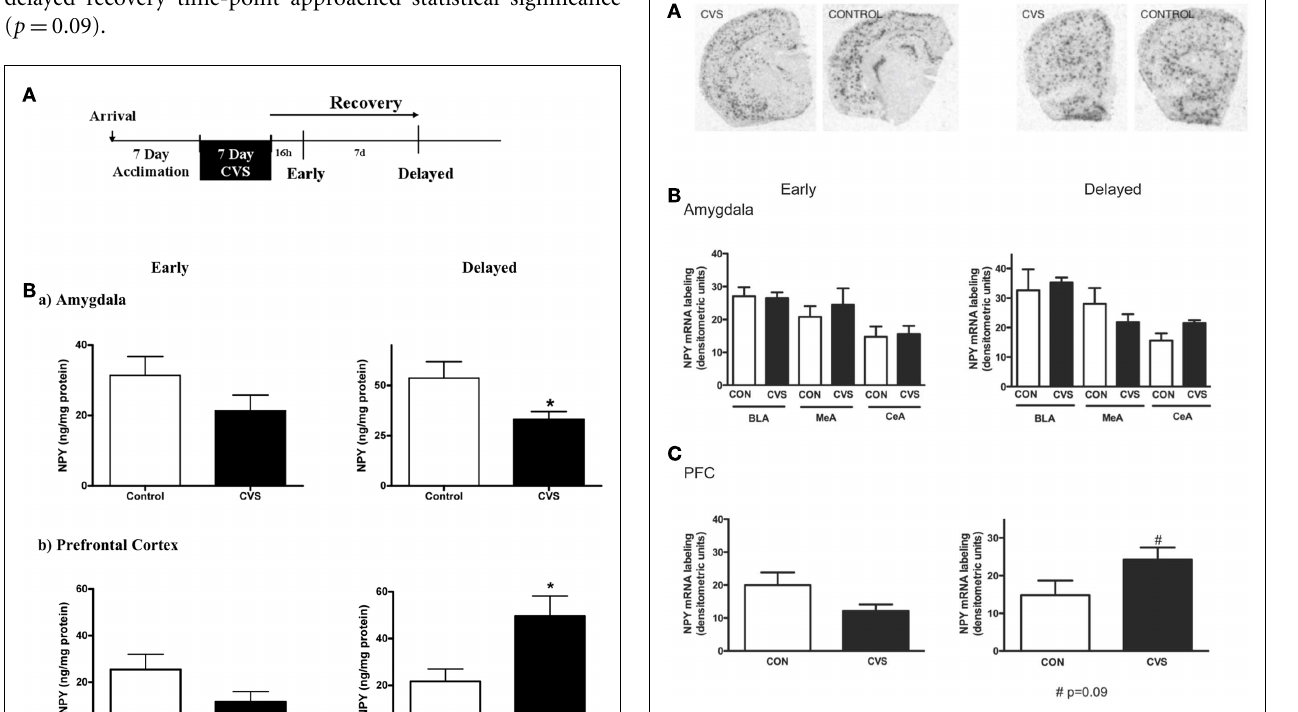
FIGURE 2 | In situ hybridization for NPY mRNA in amygdala and prefrontal cortex during recovery from CVS. (A) . Representative images of NPY in situ hybridization from control and CVS animals. (B) . Levels of NPY mRNA did not differ between CVS and control brains in basolateral, medial, or central amygdala in either early or delayed recovery. (C) . NPY mRNA in the prefrontal cortex did not differ between control and CVS animals in early and delayed recovery. However there was a trend toward increase in NPY mRNA in later recovery when NPY peptide was also increased. “#” Indicates p = 0.09. Data is represented as mean ±